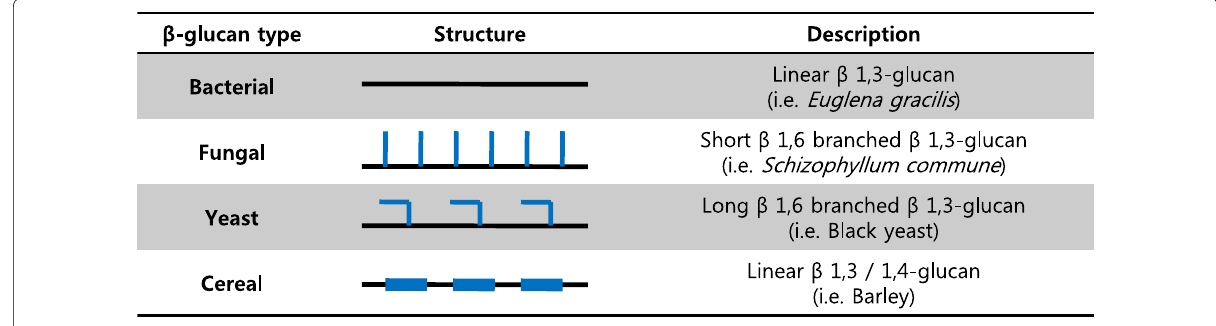
Fig. 1 The structure and description of four kinds of